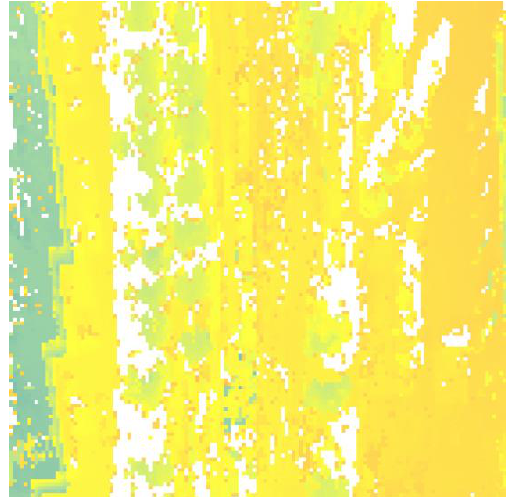
Figure 5 . Corresponding greyscale map with the highlighting of the focusing box.